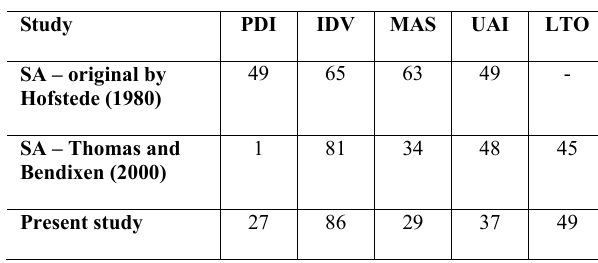
Table 3: Comparison of present results with Hofstede (1980) and Thomas and Bendixen